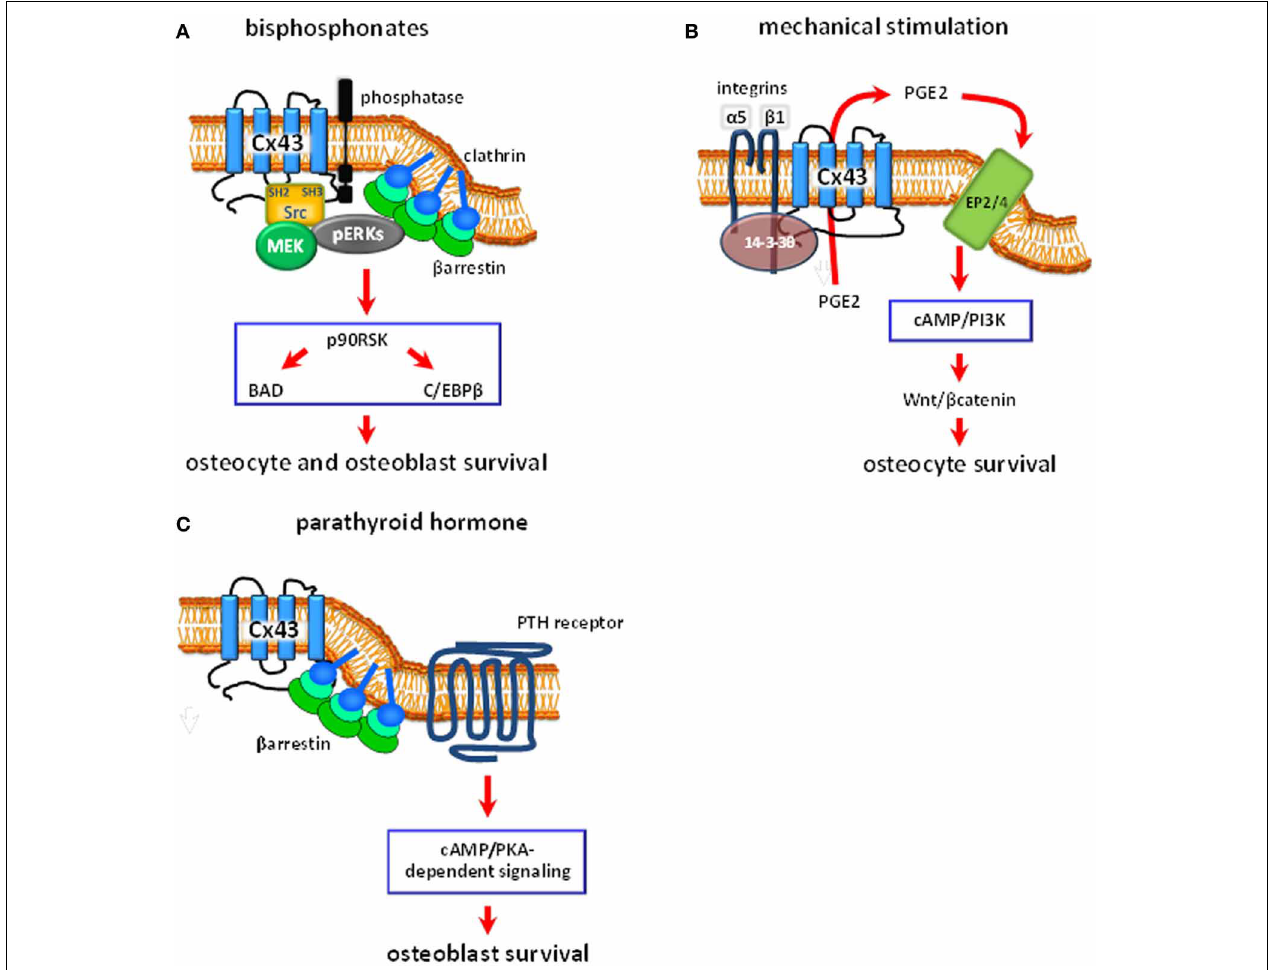
FIGURE 2 | Schematic representation of the proposed intracellular signaling pathways regulated by Cx43 hemichannels in bone cells. (A) Bisphosphonates bind to phosphatases present in the cell membrane. This induces Cx43 hemichannel opening, followed by activation of the kinases Src and MEK, and ERKs. ERKs activated downstream of Cx43 hemichannel opening are retained in the cytoplasm by a complex formed by β arrestin and clathrins. This leads to the phosphorylation of the cytoplasmic targets p90 RSK , BAD and C/EBP β , which results in osteoblast and osteocyte survival. (B) Mechanical stimulation induces α 5 β 1 integrin engagement and the association